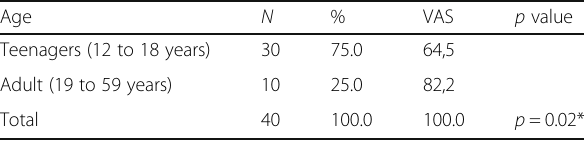
Table 4 Comparison between patient age, bracket